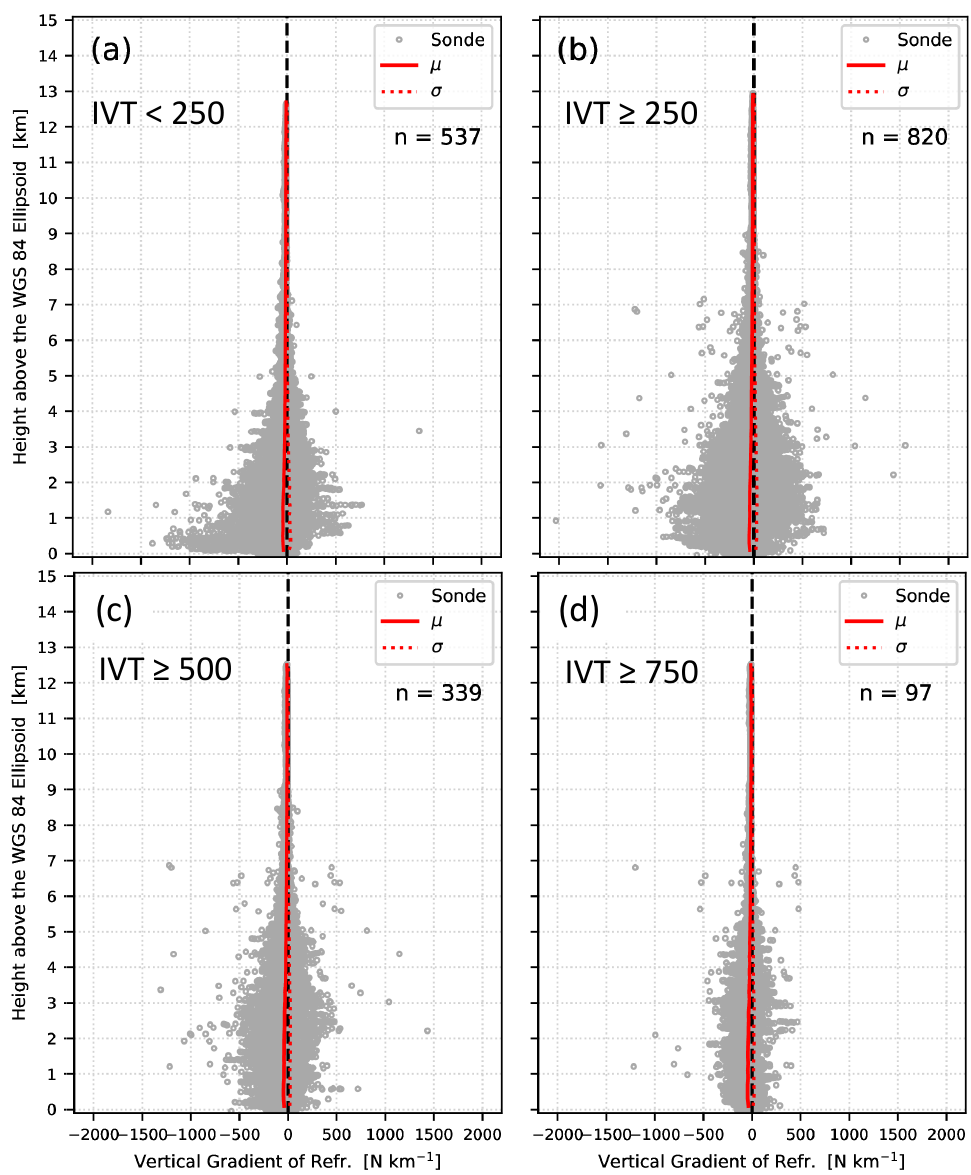
Figure 9. Vertical refractivity gradient dN/dz (N units km − 1 ) from dropsondes collected dur- ing AR Reconnaissance that sampled ( a ) outside an AR, ( b ) inside an atmospheric river based on integrated vapor transport (IVT) > 250 kg m − 1 s − 1 , ( c ) inside an atmospheric river based on IVT > 500 kg m − 1 s − 1 , ( d ) inside an atmospheric river based on IVT > 750 kg m − 1 s − 1 , (grey circles), along with the mean and standard deviation of the vertical refractivity gradient (solid and dashed red lines, respectively) computed in vertical bins with width of 200 m. The thick dashed black line highlights the line of zero difference and the number of dropsondes, n, is